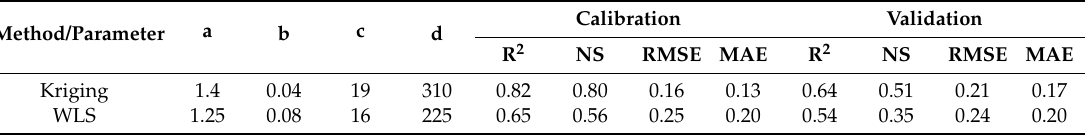
Table 4. Results of calibration and validation.